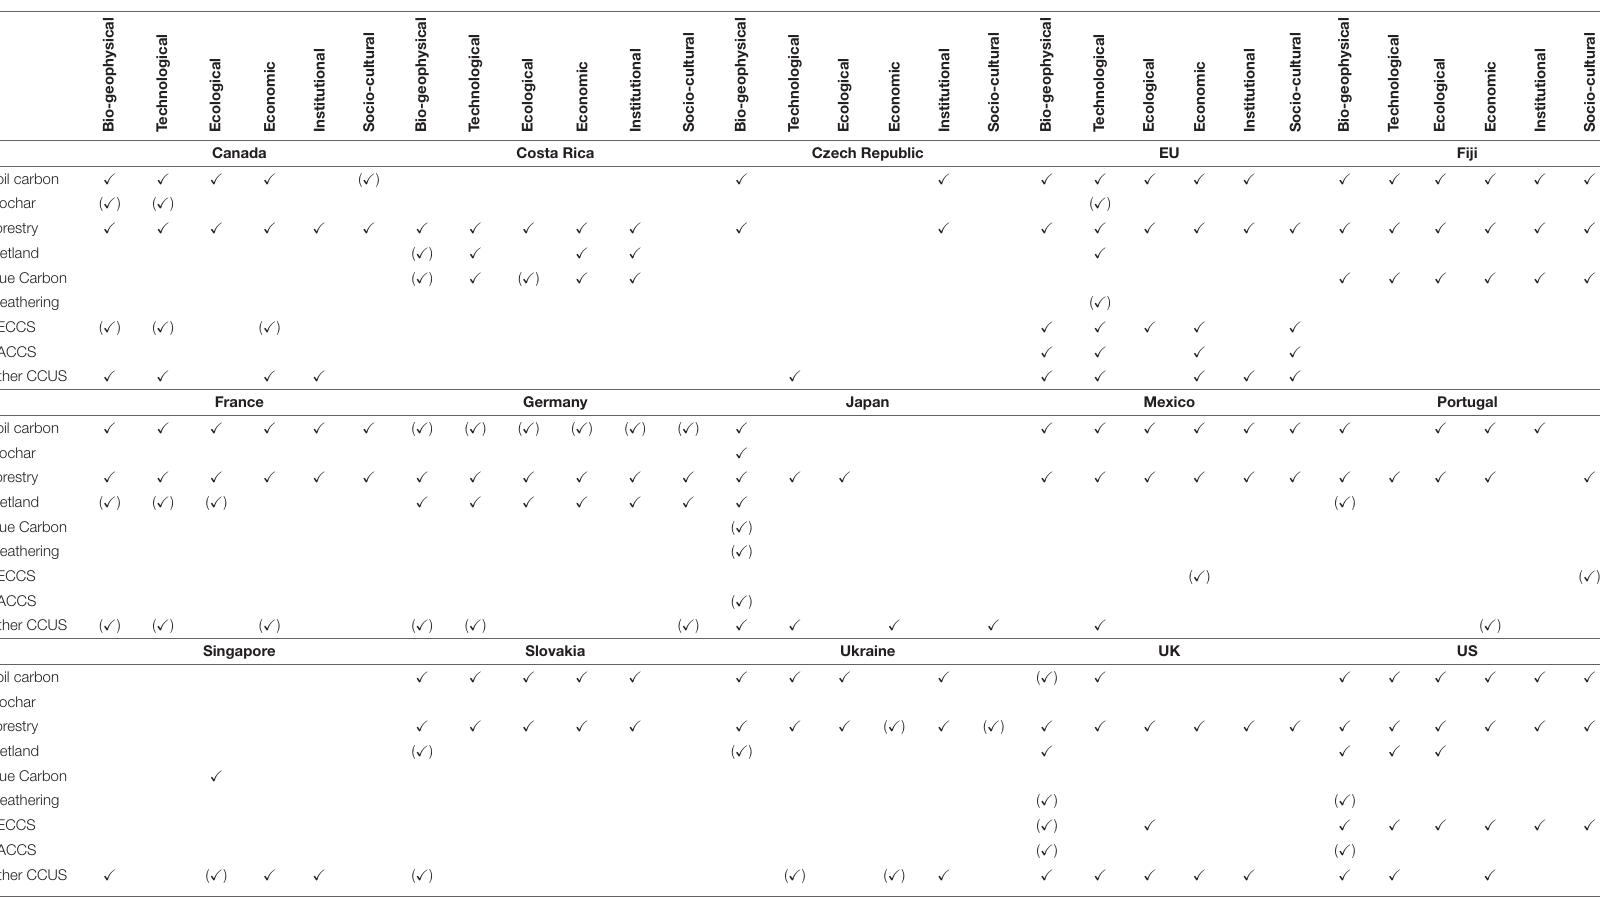
TABLE 1 | Overview of 15 Long-Term Low Greenhouse Gas Emission Development Strategies (LT-LEDS) submitted to the United Nations Framework Convention on Climate Change (UNFCCC) as of July